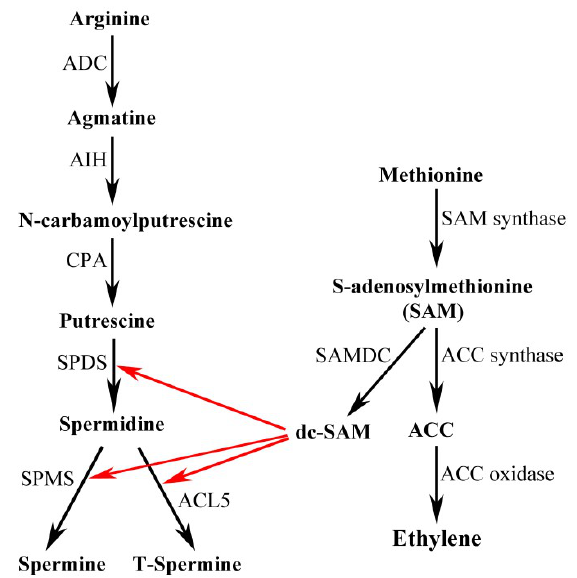
Figure 1. Polyamine biosynthesis pathway in Arabidopsis thaliana . ADC, arginine decarboxylase; AIH, agmatine iminohydrolase; CPA, N -carbamoylputrescine amidohydrolase; SPDS, Spd synthase; SPMS, Spm synthase; ACL5, ACAULIS5, T-Spm synthase; SAM, S -adenosylmethionine; SAMDC, S -adenosylmethionine decarboxylase; dcSAM, decarboxylated S -adenosylmethionine; ACC, 1-amino-cyclopropane-1-carboxylic-acid.